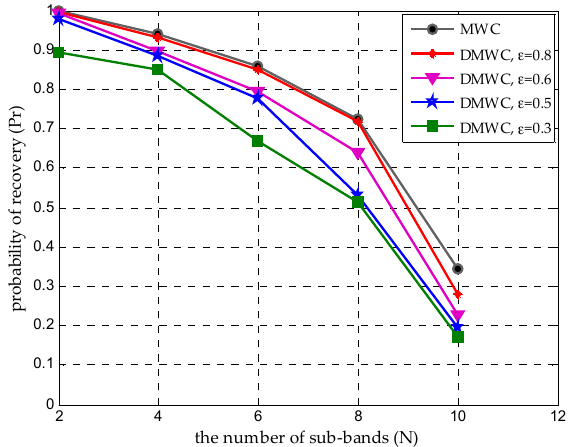
Figure9. Probability of support recovery under time-varying S at different  when 50 m  . Figure 9. Probability of support recovery under time-varying S at different ε when m =